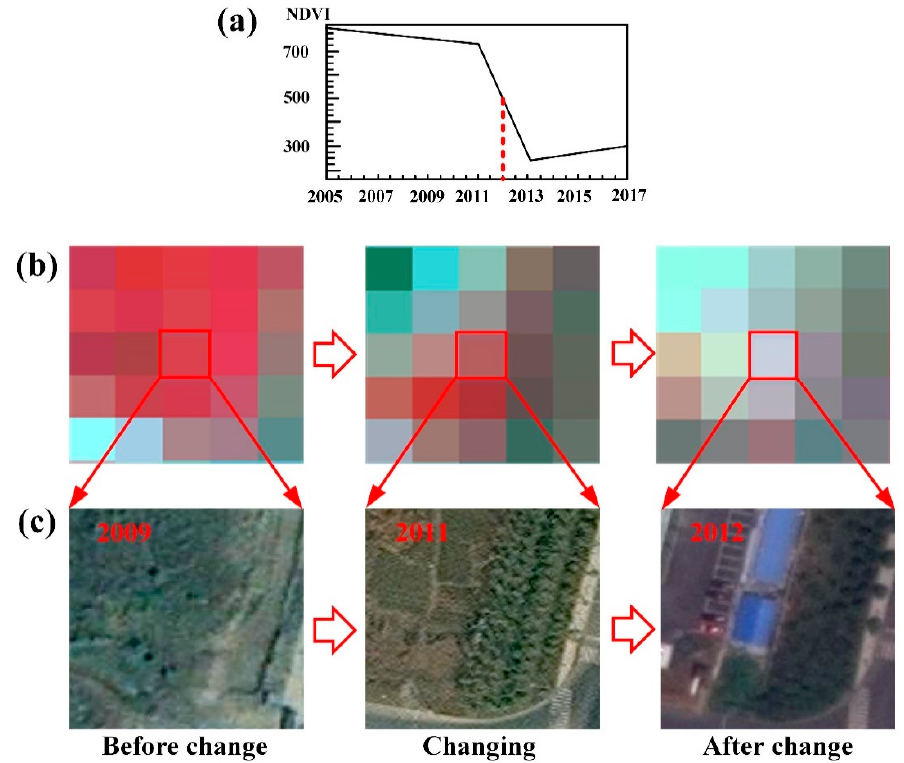
Figure 14. Effects of mixed pixels on time monitoring accuracy. ( a ) Sample trajectory, where the red dotted line indicates the detected change time. ( b ) Landsat images of the sample. ( c ) High-resolution images of the sample from Google Earth.